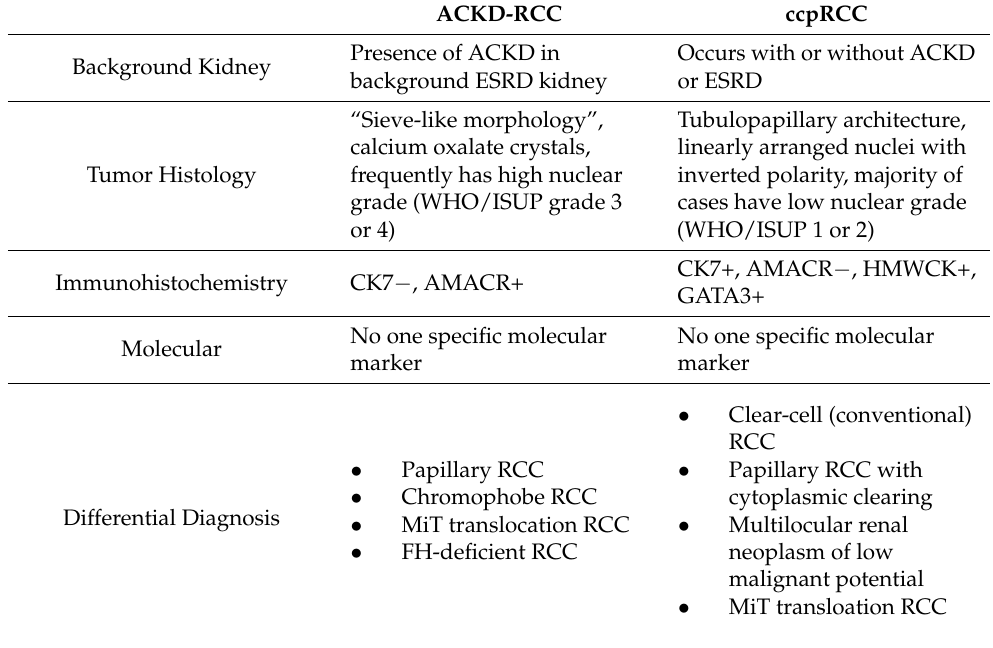
Table 5. Summary of diagnostic features and differential diagnosis of ACKD-RCC and